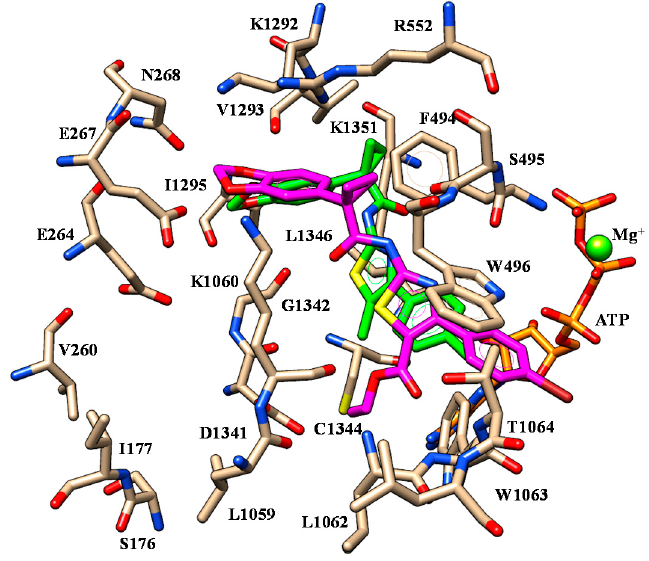
Figure 9. Selected docking mode of 3 (C atom; magenta) and 6 (C atom; green) within the modelled F508del-CFTR. The most important residues are labelled.